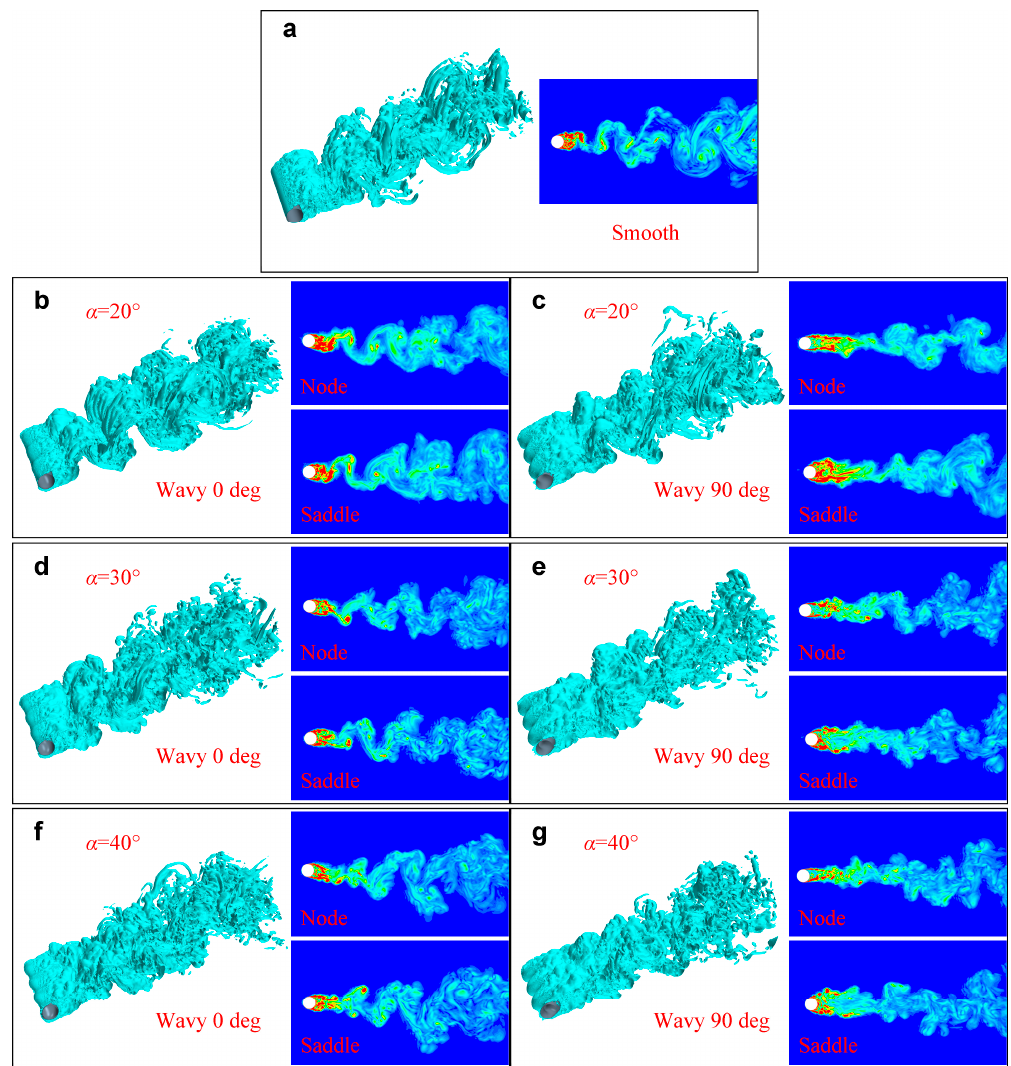
Figure 14. Comparison of the instantaneous three-dimensional vortices magnitude and spanwise two-dimensional vorticity isosurfaces of the smooth cylinder and three wavy cylinders. Here, ( a ) smooth cylinder; ( b ) α = 20° and θ = 0°; ( c ) α = 20° and θ = 90°; ( d ) α = 30° and θ = 0°; ( e ) α = 30° and θ = 90°; ( f ) α = 40° and θ = 0°; ( g ) α = 40° and θ = 90°.